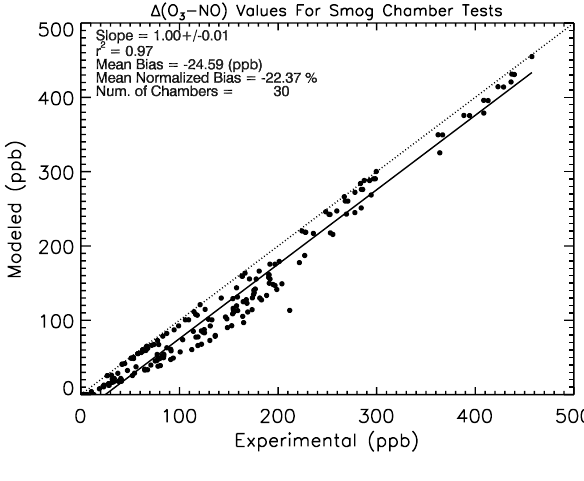
Figure 1. ASP calculated hourly values of (cid:49) ([O 3 ] − [NO]) ≡ ([O 3 ] final − [NO] final ) − ([O 3 ] initial − [NO] initial ) vs. the values measured in the EPA chamber of Carter et al. (2005) for 30 “full surrogate” experiments. Note that all time points for the 30 chamber experiments are plotted, not just the final